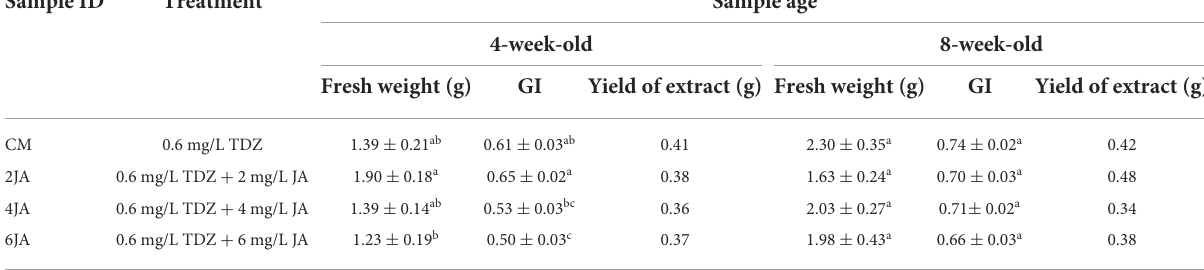
TABLE 1 Effect of TDZ and JA concentrations on callus fresh weight, growth index and yield of extracts. Sample ID